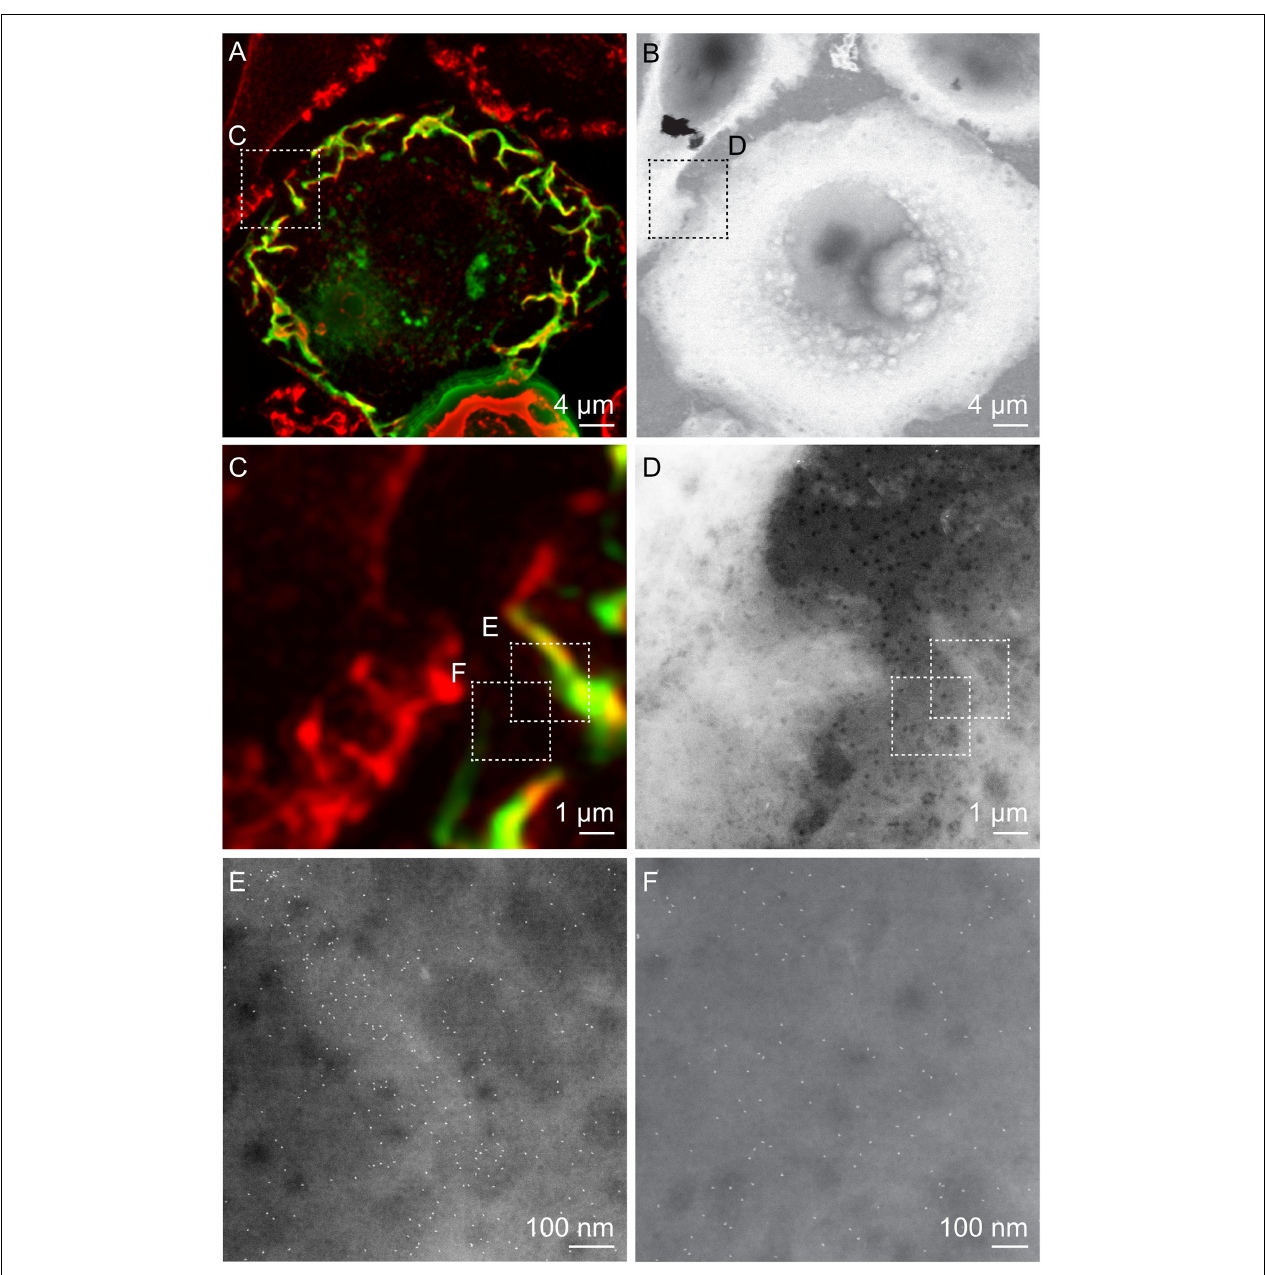
FIGURE 2 | Correlative FM and STEM of whole breast cancer cells. (A,C) Cropped fluorescence micrographs of SKBR3 breast cancer cells showing cellular actin-GFP in green and QD-labeled membrane ErbB2 in red. Areas where both signals overlap appear yellow. Actin-containing ruffles can be identified as bright green and yellowish lines at the cell edges. (B,D) Corresponding STEM micrographs of graphene-covered breast cancer cells acquired at the same spots. B: Magnification M = 1,000 × , D: M = 4,000 × . (E,F) STEM micrographs of regions marked in C, and D acquired at higher magnification than in D. QD-labels appear as white dots. Membrane ruffle in E appears in a light gray shade compared to flat cell regions in F, appearing in a darker gray, E: M = 100,000 × , F: M = 120,000 × .